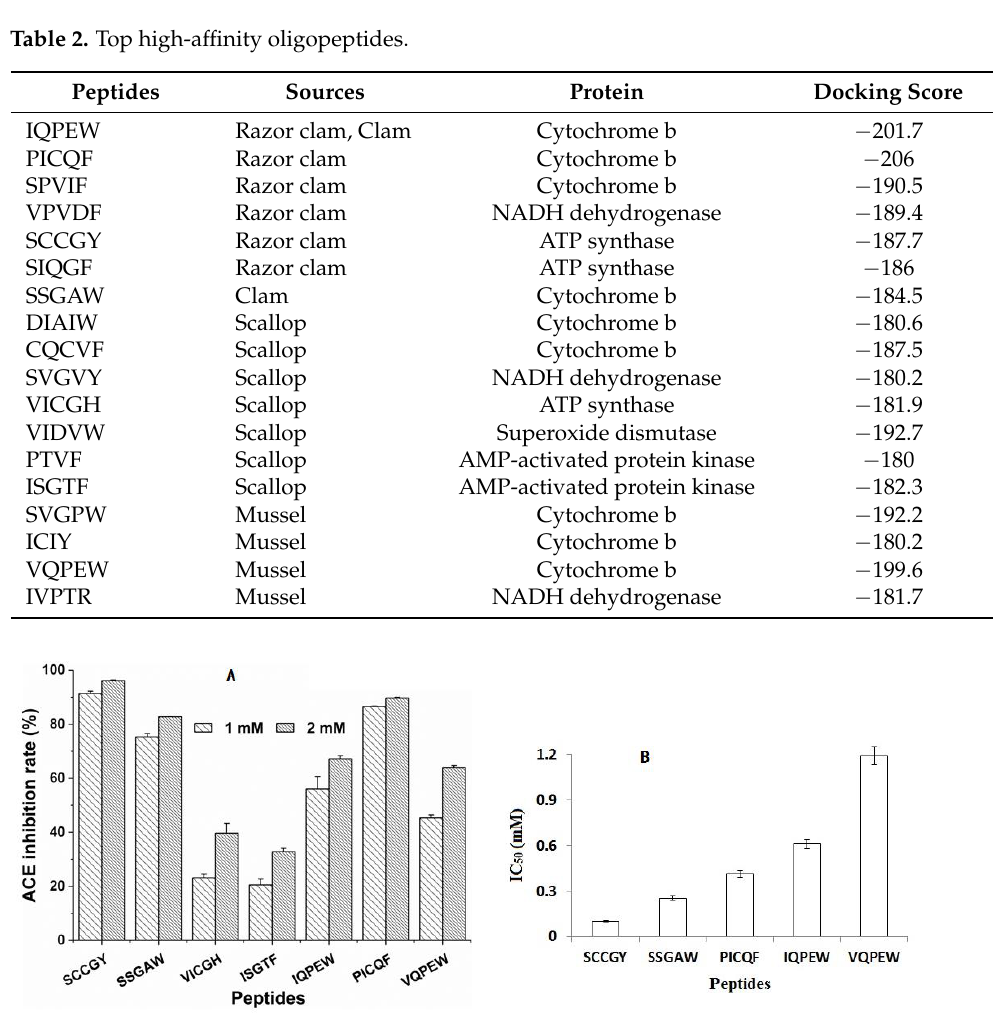
Figure 2. Inhibitory activities of the synthesized peptides on angiotensin-converting enzyme ( A ) and IC50 values (mM) ( B ). The selected oligopeptides (PICQF, IQPEW, VQPEW, SCCGY, SSGAW, VICGH, and ISGTF) were synthesized by a standard solid-phase method (Yuanpeptide Co., Ltd. Nangjing, China). The samples (50 µ L, 1 mg/mL) and enzymes (50 µ L, pH 8.3, 150 mM Tris HCl buffer solution) were mixed and incubated at 37 ◦ C for 10 min, and then the substrate (200 µ L, 0.45 mM) ABZ Gly phe-(NO2)-Pro and buffer solution (pH 8.3, 1.125 M NaCl, 150 mM Tris HCl) were added and reacted at 37 ◦ C for 30 min. The fluorescence intensity (FLU) of the product, o-aminobenzoylglycine (ABZ-Gly), was immediately determined at the excitation wavelength λ ex = 355 nm and the emission wavelength λ em = 405 nm. The control group was combined with buffer (50 µ L) and enzyme (50 µ L). The background group was combined with sample solution (50 µ L) and buffer (50 µ L). The ACE enzyme inhibition rate was calculated. Each treatment was performed in triplicate, the values were expressed as mean values ± standard deviation, the significance level between different groups was p < 0.05, and statistical analysis was conducted by a one-way ANOVA using SPSS 22.0 (SPSS Software Inc., Chicago, IL, USA).